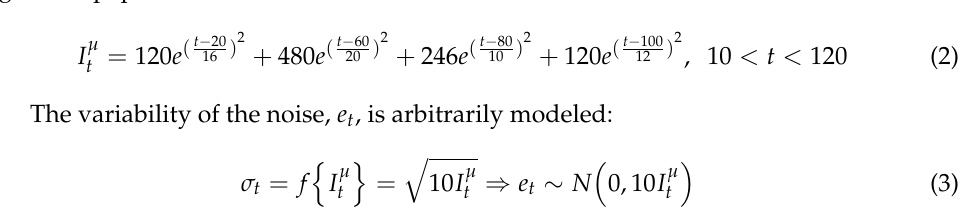
Figure 1. Partial series of incidence and smoothed incidence (mean) of the COVID-19 pandemic, Panama 2020, showing a typical pattern of variation around the mean.